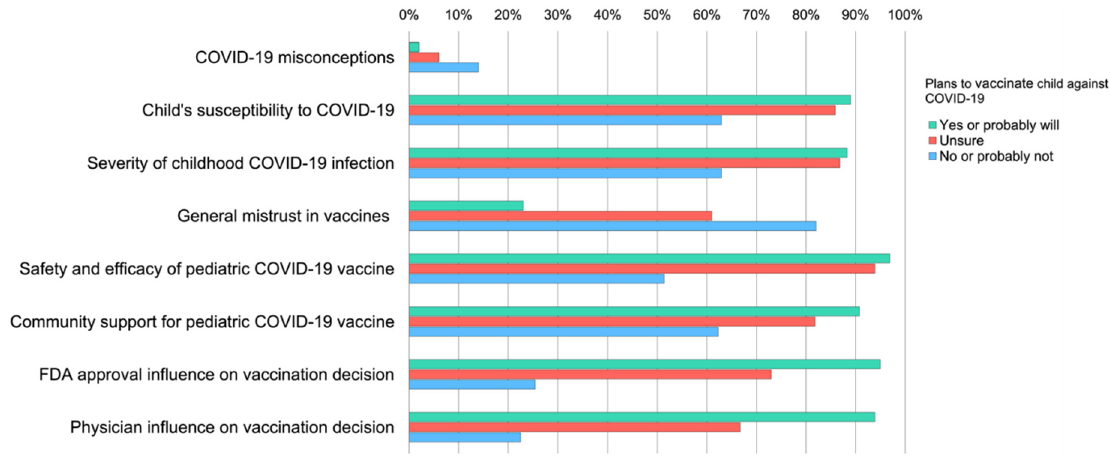
Figure 1. Endorsement of factors influencing pediatric COVID-19 vaccine acceptance and hesitancy by parents’ plans to vaccinate their child against COVID-19. Chi-square tests of association with Bonferonni adjusted p -values indicated significant differences among parental plans to vaccinate their child against COVID-19 for all factors, p < 0.001.